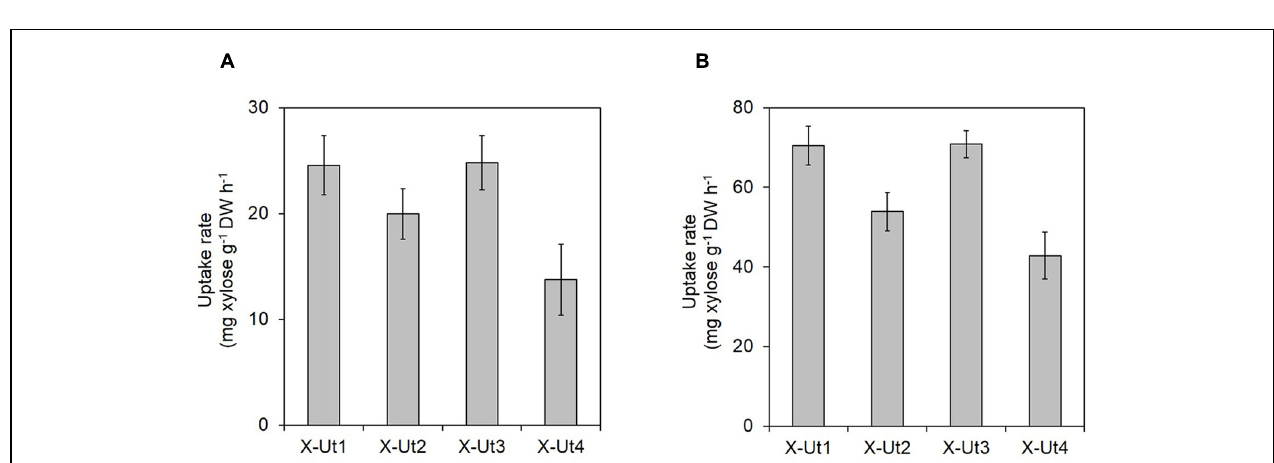
FIGURE 10 | Maximum xylose uptake rates in the presence of 5 mM xylose. Synechocystis strains X-Ut1, X-Ut2, X-Ut3, and X-Ut4, were grown in the presence of 5 mM (750 mg/L) xylose. Maximum xylose uptake rates [mg xylose g − 1 dry weight (DW) h − 1 ] under (A) LAHG and (B) mixotrophy conditions were calculated using a previously described formula (Munyon and Merchant, 1959). For all the strains, maximum xylose uptake rates were observed between the sixth and seventh day under LAHG. Under mixotrophy, maximum xylose uptake rates were observed between the 42 and 48 h (for X-Ut1, X-Ut3, and X-Ut4) and the 48 and 54 h (for X-Ut2). Raw data were collected from three biological replicates. Uptake rates are presented as means ± standard